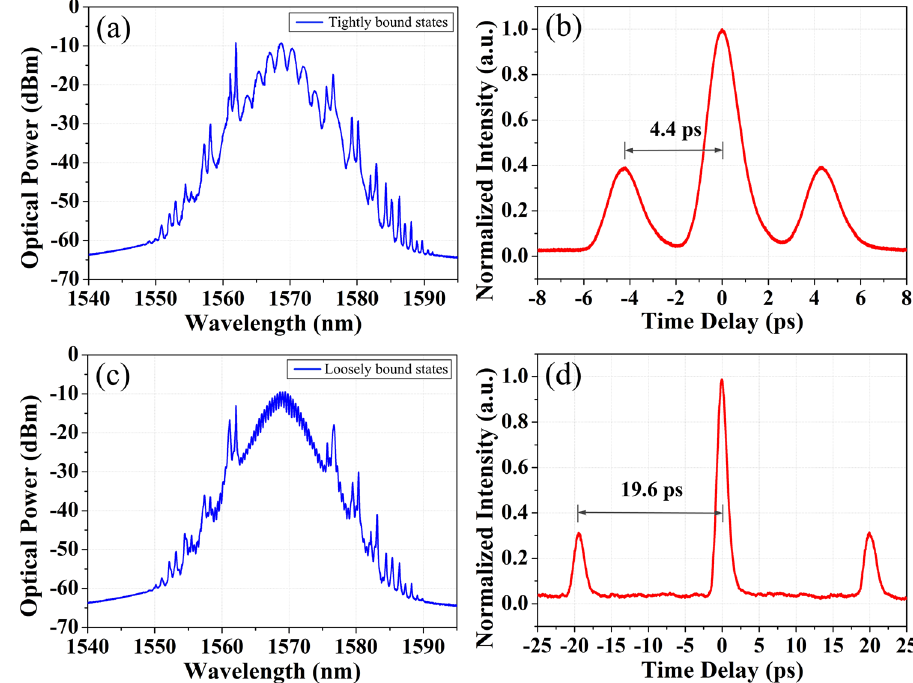
Figure 6. Tightly/loosely bound states. ( a ) Optical spectrum and ( b ) autocorrelation trace of the tightly bound state; ( c ) optical spectrum and ( d ) autocorrelation trace of the loosely bound state.